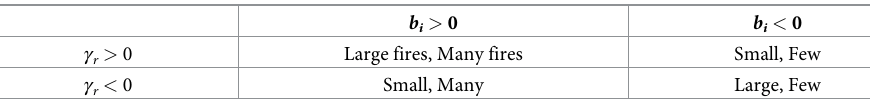
Table 1. Interpretations of the linking